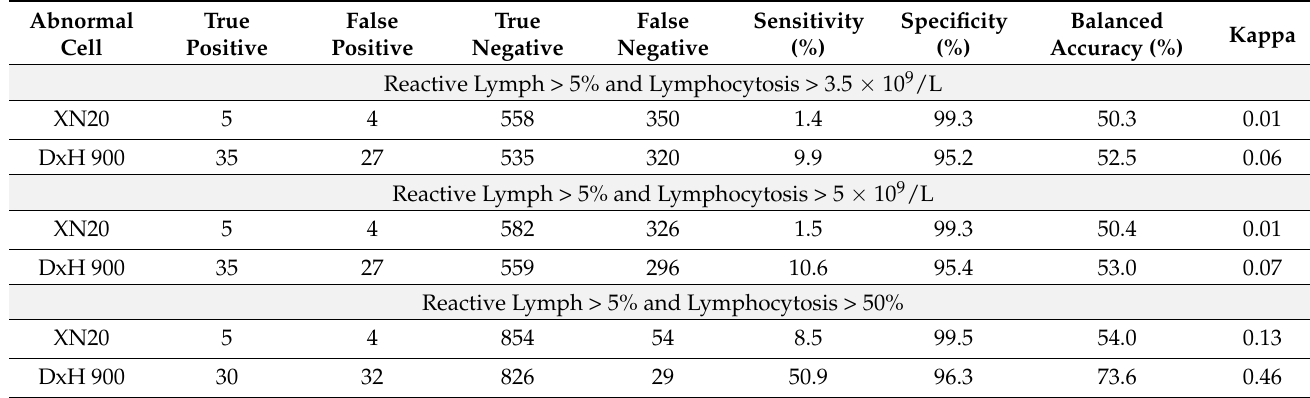
Table 8. Reactive lymphocyte detection (reference method cut-off) and variant lymph: sensitivity and specificity in the DxH 900 and the